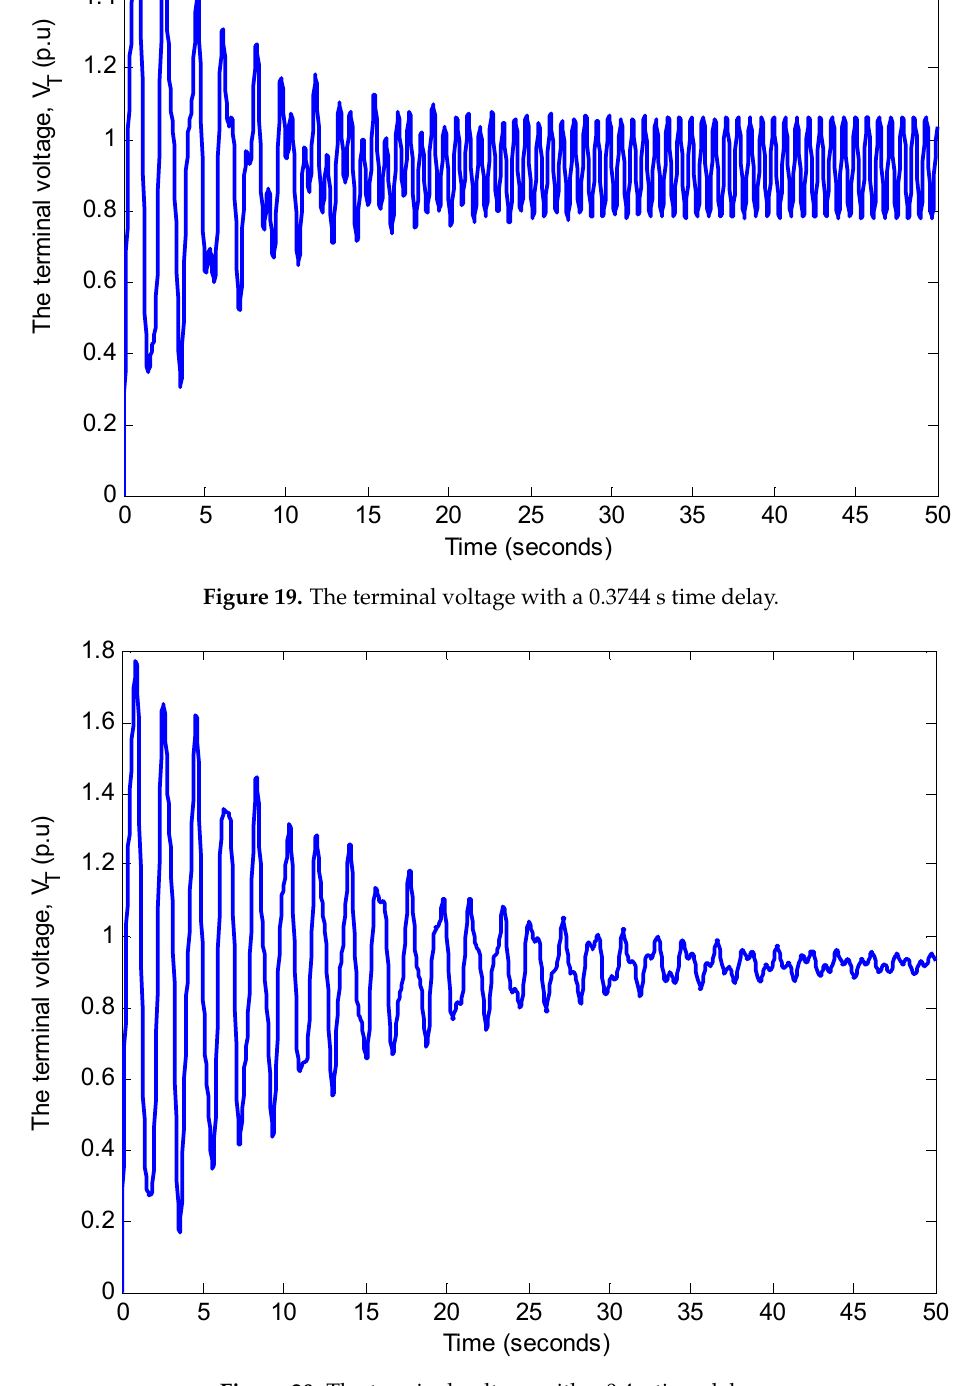
Figure 20. The terminal voltage with a 0.4 s time delay.